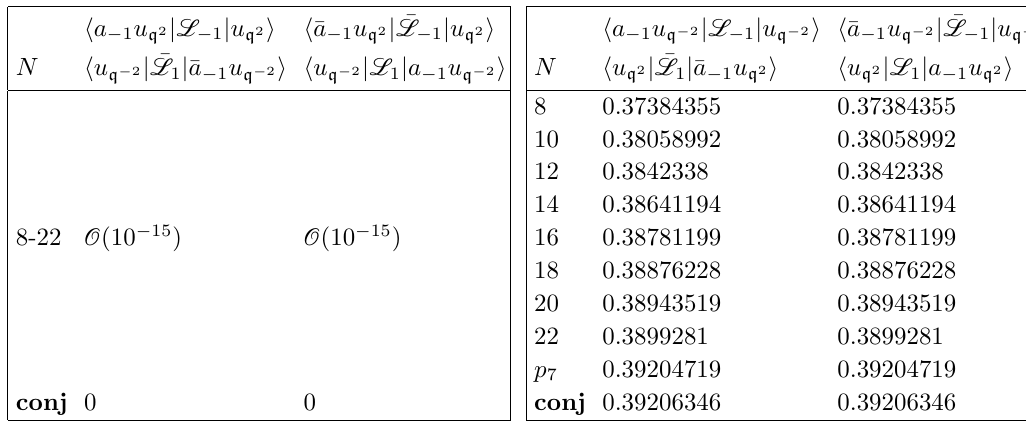
i the primary state q 2 , and j u i the 0 ; q 2 q (cid:0) 2 0 ; q (cid:0) 2